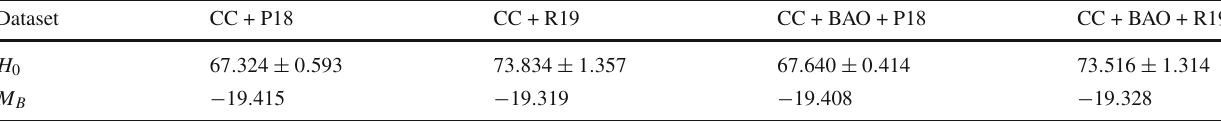
Table 4 Table showing the effect of local (R19) and global (P18) measurements of Hubble parameter on reconstructed value of H 0 , and the corresponding marginalized constraints on the absolute magnitude M B of SN-Ia